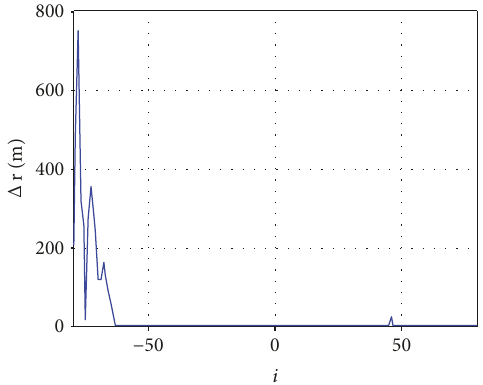
Figure 5: Predicted time and actual time with parameter i